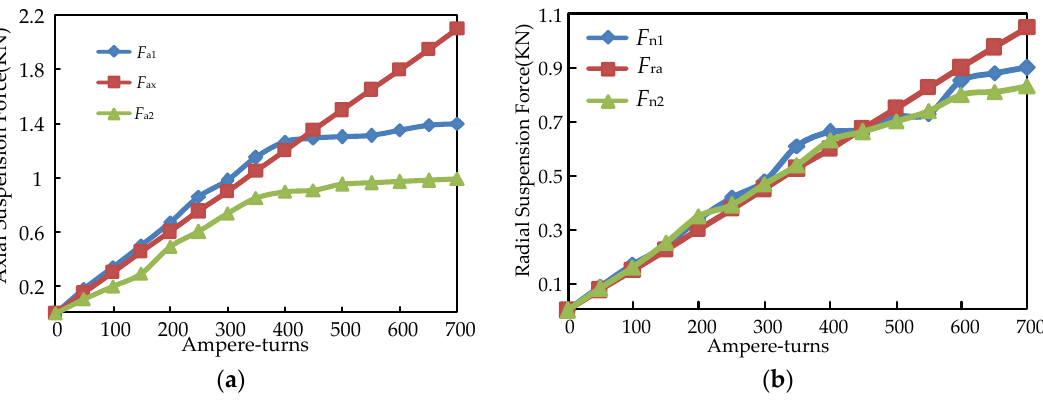
Figure 11. A comparison between the precision equivalent magnetic circuit and two kinds of HMB. ( a ) Axial suspension force versus ampere-turns; ( b ) radial suspension force versus ampere-turns.